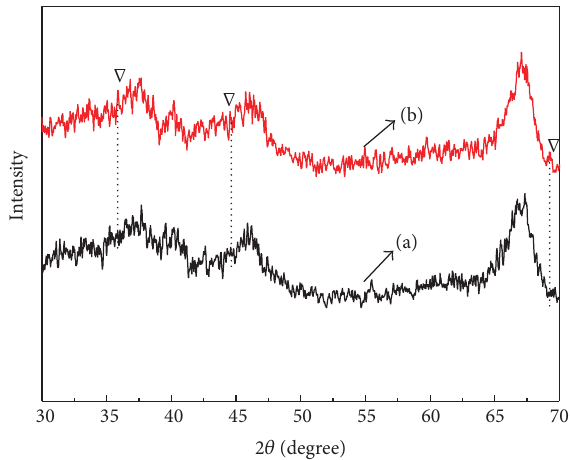
Figure 8: The XRD patterns of 1% Pd/Al 2 O 3 before and after reaction. (a) 1% Pd/Al 2 O 3 ; (b) 1% Pd/Al 2 O 3 after reaction.